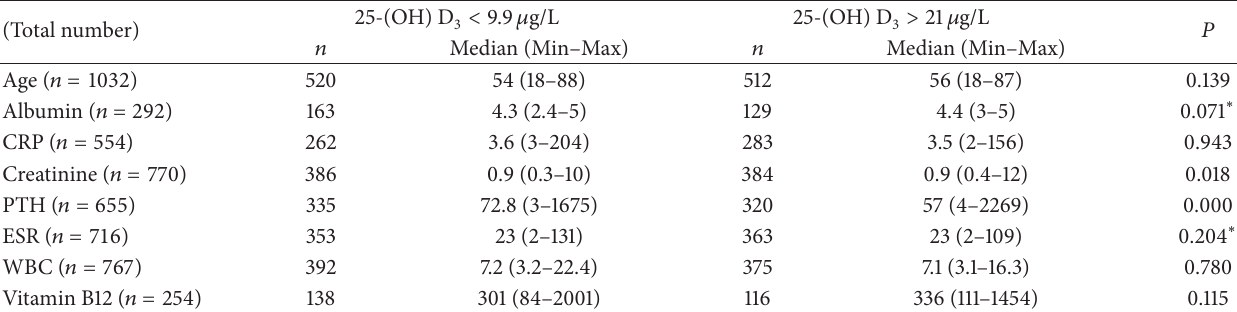
Table 3: Vitamin D deficient and normal group medians in all outpatients 3